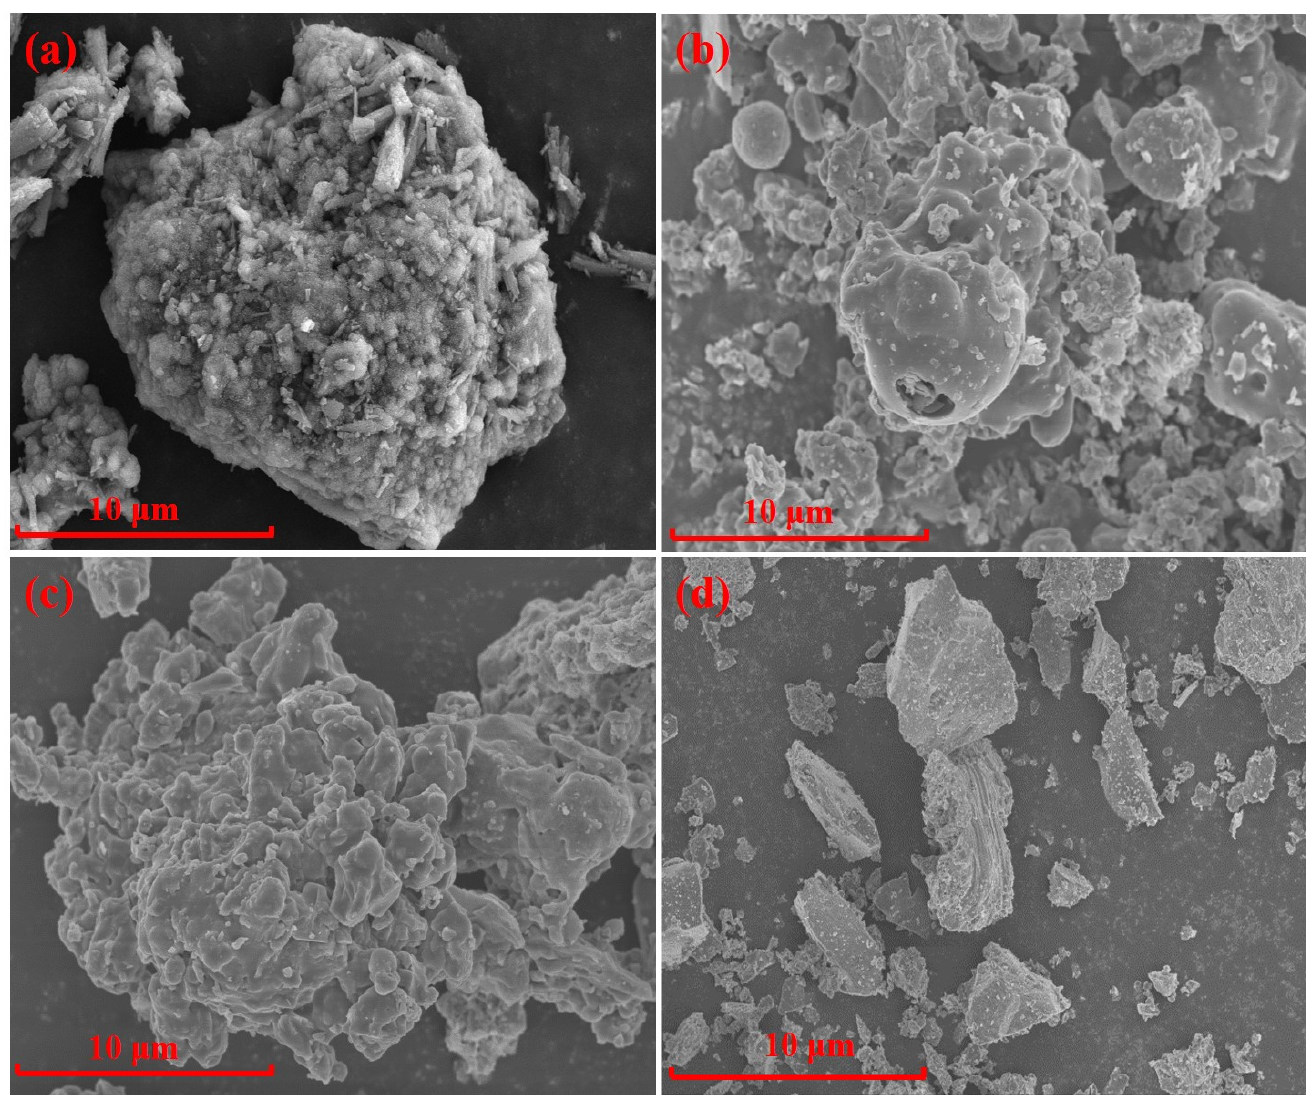
Figure 2. SEM of raw materials: ( a ) AD; ( b ) Fly ash; ( c ) Silica dust; ( d ) Gangue.